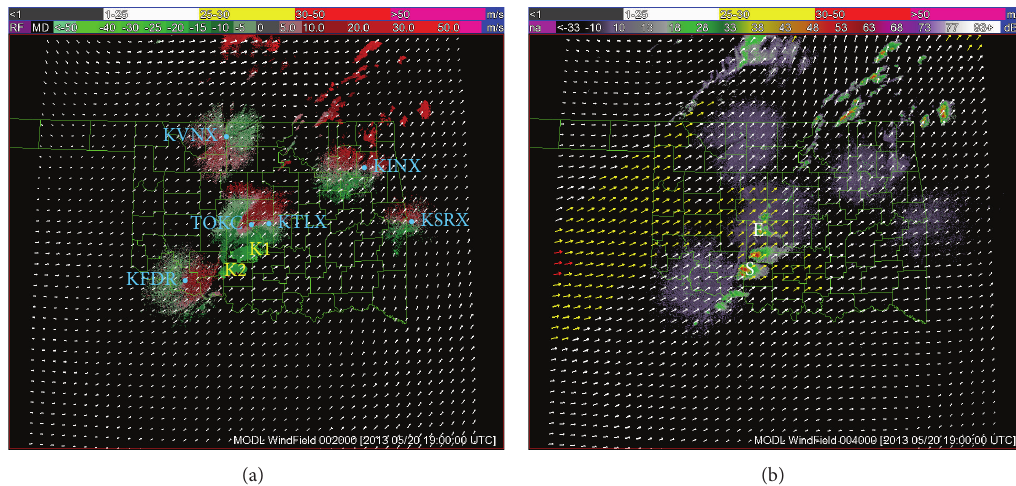
Figure 7: Background wind fields (a) at 𝑧 = 2 km superimposed on the dealiased radial-velocity images and (b) at 𝑧 = 4 km superimposed on the reflectivity images scanned at 0.5 ∘ tilt from six radars (KTLX, KFDR, KINX, KVNX, KSRX, and TOKC) around 1900 UTC on May 20, 2013. The background winds are plotted every 20 km in 𝑥 - and 𝑦 -directions by the white ( < 25ms −1 ), yellow (between 25 and 30 ms −1 ), and red ( > 30ms −1 ) arrows with the color scales shown in the first bar on the top of each panel, while the second bar on the top of (a) (or (b)) shows the color scales for the radial-velocity images (or reflectivity images). Each radar site is marked by a blue dot with the radar name in (a). The dealiased radial-velocity image from TOKC is plotted atop the image from KTLX and the latter is plotted atop the image from KFDR in (a). Because of this, the image from KTLX is mostly covered by the image from TOKC except for the two green patches marked by the yellow letters K1 and K2 to the southwest of the KTLX radar site (beyond the 50 km radial range), while the scattered red image along the southern edge of the second green patch (marked by the yellow letter K2) was scanned from KFDR. In (b), the white letter S marks the supercell that was further intensified during the next two hours, while the white letter E marks the emerging storm cell that developed into a supercell and generated a devastating tornado over the Moore area in the central Oklahoma in the subsequent 1 hour (around 2000 UTC). The analysis domain size is 800 × 800 × 10 km 3 . The green lines plot the county boundaries .